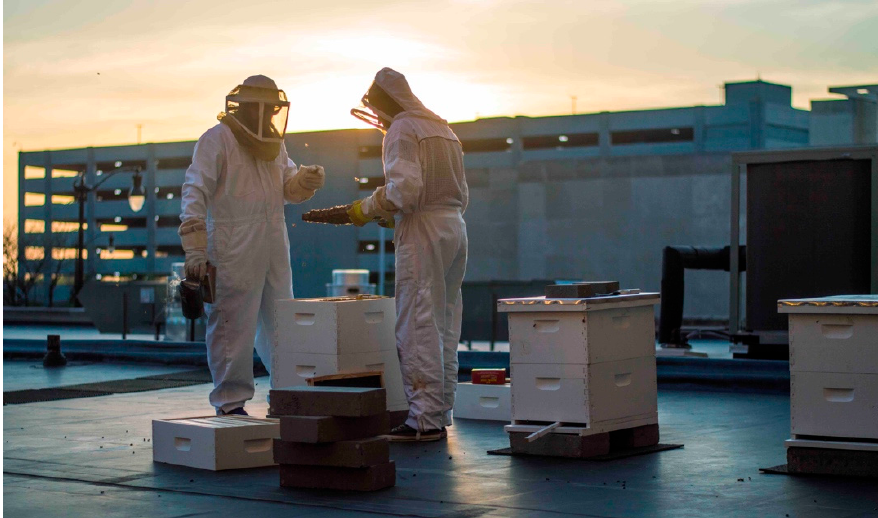
Figure 1 . Roof top hives in the city of Detroit (‘Bees in the D’). Photo: Colin McConnell. Figure 1. Roof top hives in the city of Detroit (‘Bees in the D’). Photo: Colin